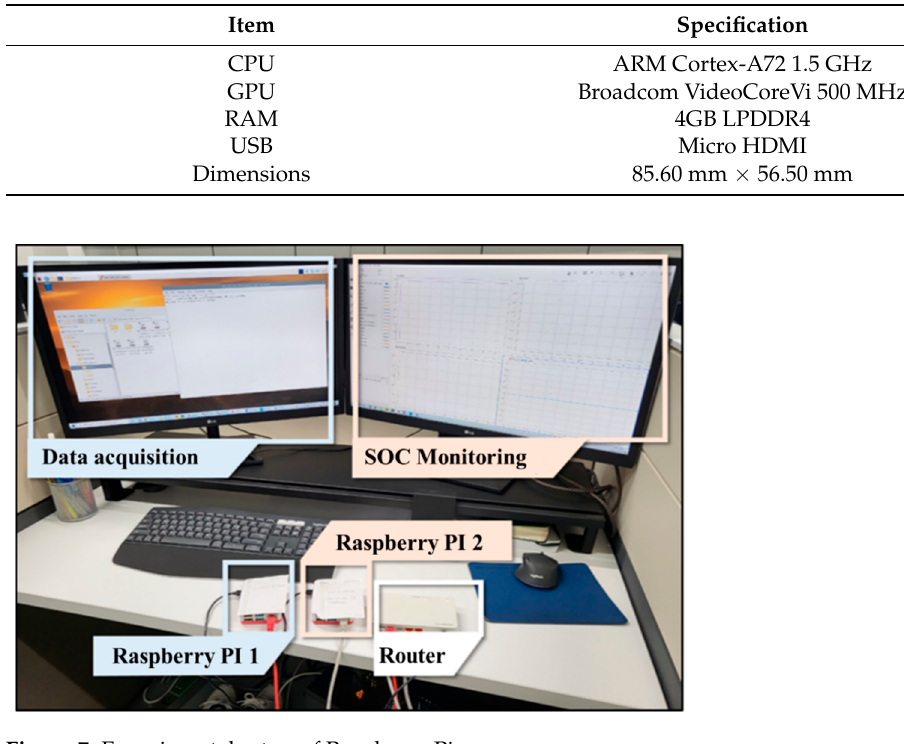
Figure 8. Scheme of communication protocol between Raspberry Pi. 3.2. Residual SOC between Simulation and Embedded Board Figure 9 shows the SOC estimation results between the embedded board and simu- lation using the same setup. The simulation result had a value close to that of the actual SOC estimate, but it demonstrated a difference of up to 0.8% from the actual SOC when an embedded board was used, despite having the same model conditions. This is caused by data precision.